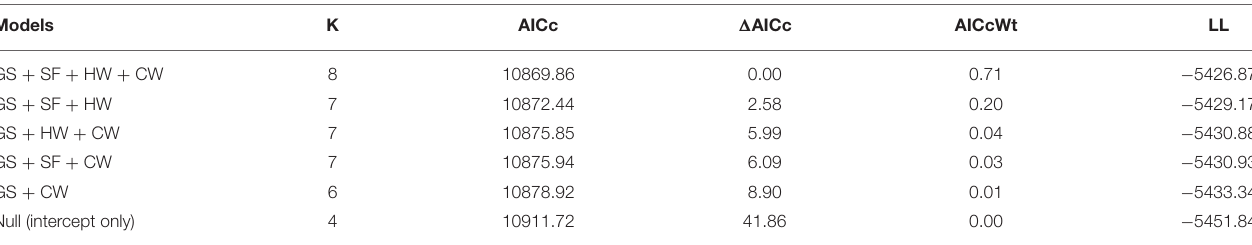
TABLE 3 | Model selection table showing the five best models of annual tree growth in the southern study region.